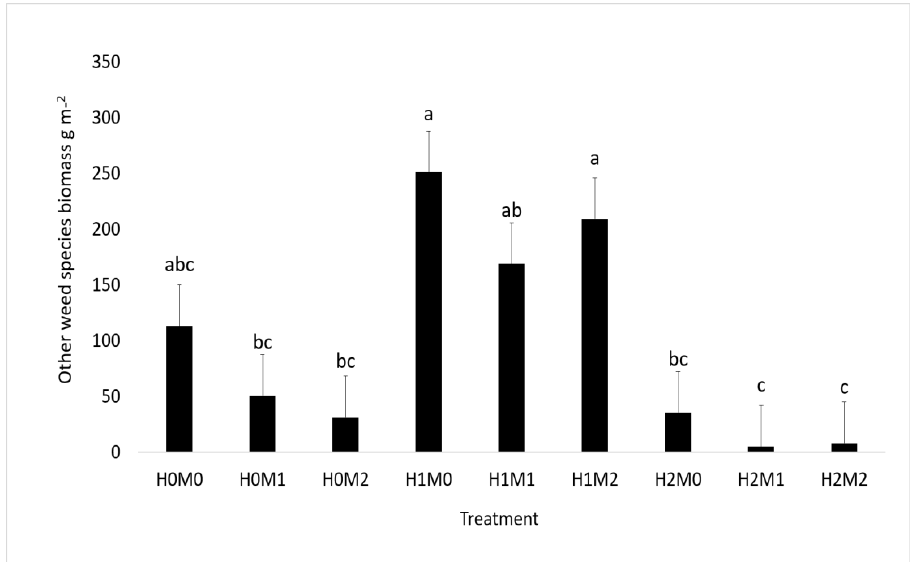
Figure 5. Mean (± pooled SE) OWS biomass (g∙m −2 ) present as a result of the interaction between herbicide and mowing after 24 months in a barley grass-infested mixed pasture stand. Bars with the same letter are not significantly different ( p < 0.05) after the Scheffe correction for type I error. H0, H1, H2: no herbicide, herbicide 1 (propaquizafop), herbicide 2 (paraquat), respectively. M0, M1, M2: no mow, one mow, repeat mow, respectively.